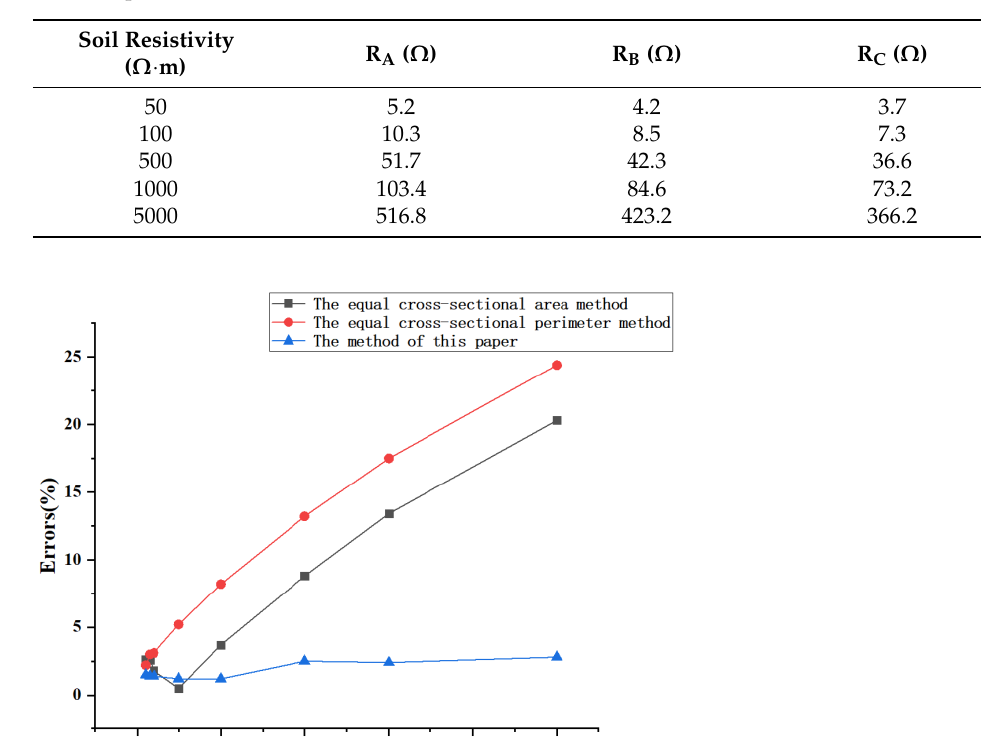
Table 5. Power frequency grounding resistances under different soil resistivities in the equal cross- sectional perimeter method.